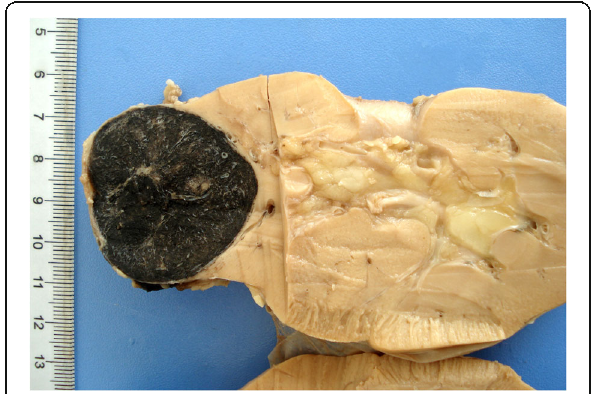
Fig. 1 The well-defined tumor exhibited black pigment throughout the lesion on the cut